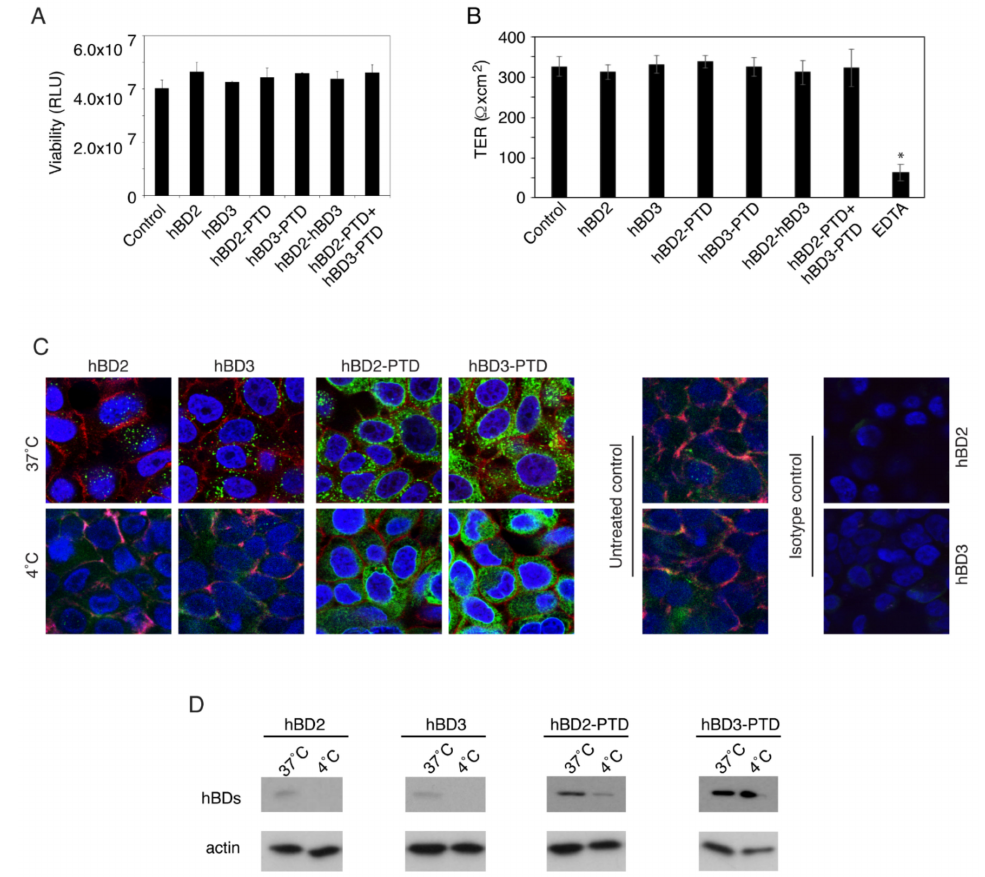
Figure 1. Protein transduction domain (PTD)-mediated penetration of polarized tonsil epithelial cells by hBD-2 and hBD-3. ( A ) hBD-2 and -3 proteins, with or without PTD signal, were added to the apical surface of polarized tonsil epithelial cells (100 µ g/mL). Cells were also incubated with a combination of hBD-2 and -3 (50 µ g/mL of each). After 24 h, cells